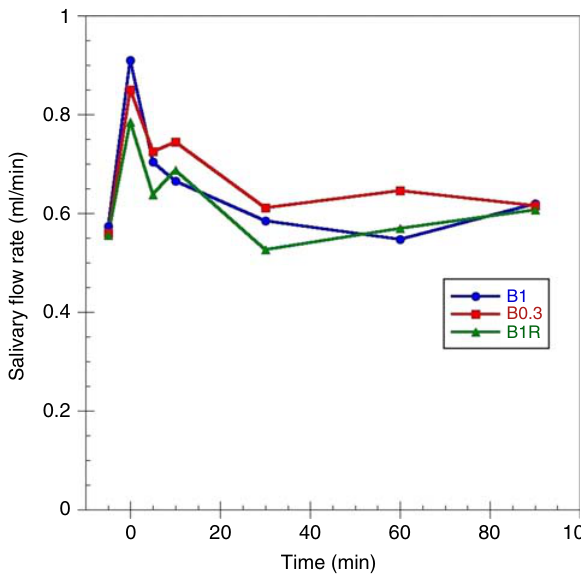
Figure 3. Mean salivary flow rate at specific time points of B1, B0.3 and B1R